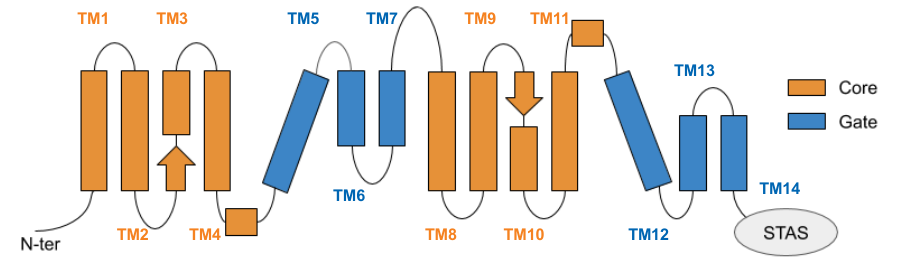
Figure 4. Schematic representation of the transmembrane domain of prestin, located between the N-terminal and the cytoplasmic, anti-sigma factor antagonist (STAS) domain. Helices are arranged according to a 7 transmembrane inverted repeat fold; they are conventionally indicated from 1 to 14, starting from the N-term, and are divided among the gate and core domains. The two arrows represent the short β -strands hosting the putative binding site of chloride